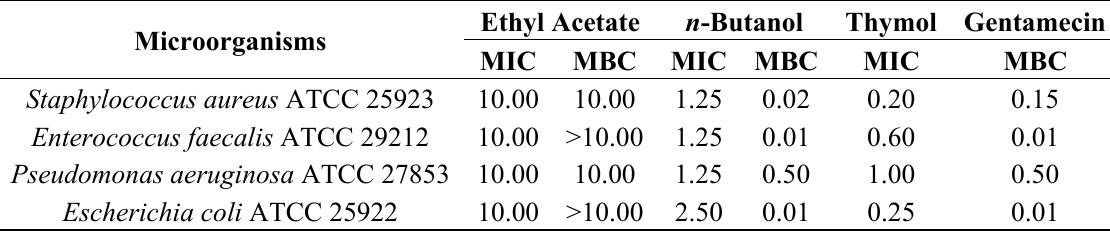
Table 5. Antibacterial activity of F. lutea